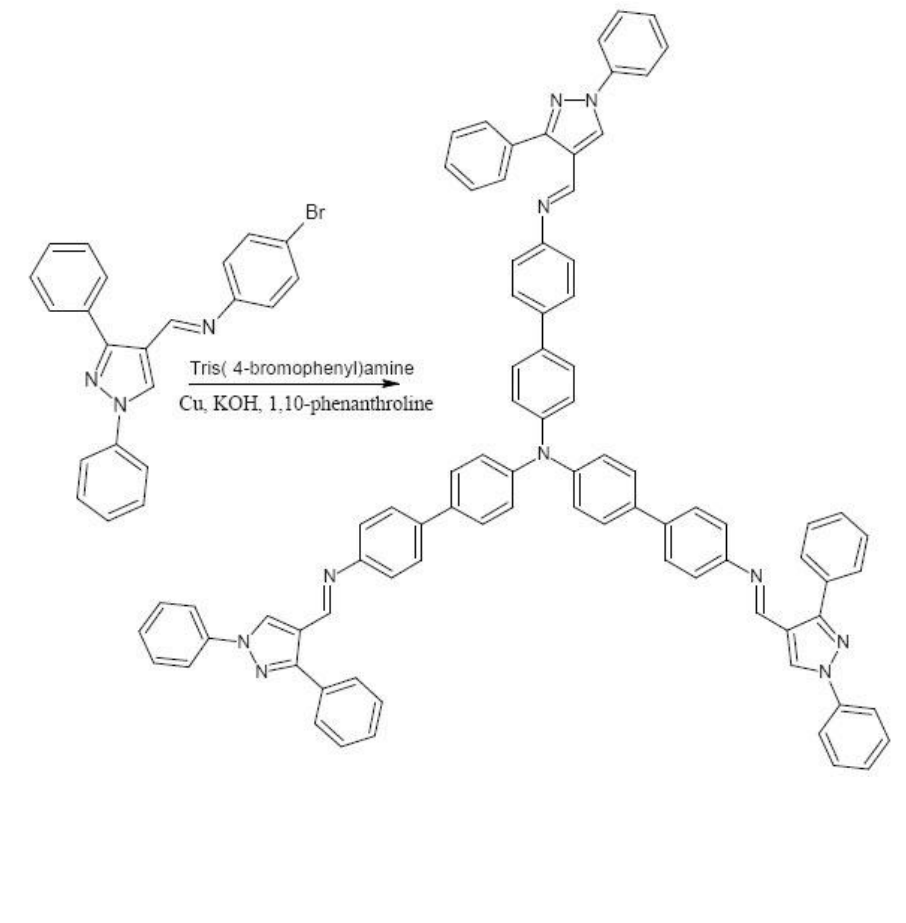
Scheme 1. Synthesis of tris{4-[(1,3-diphenyl-1 H -pyrazol-4-yl)methylene]-4 1 -amino-